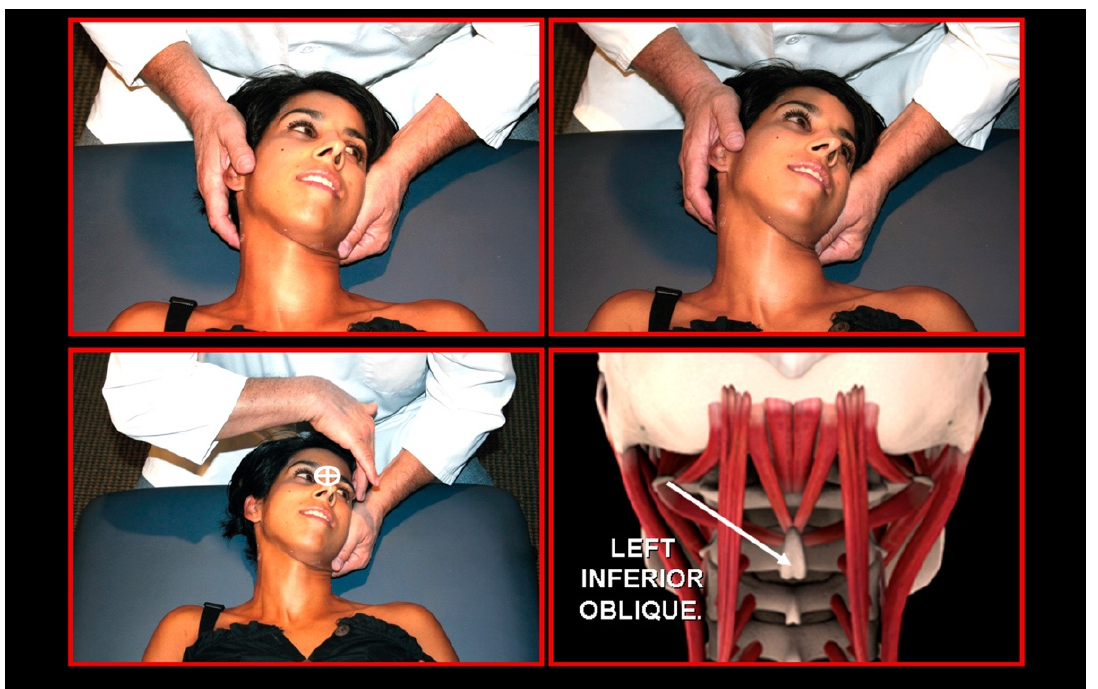
Figure 23. Atlas derotation, left direction. Source: Rocabado Institute, Chile. Employing left inferior oblique and right anterior rectus capitis muscles using neuromuscular techniques.